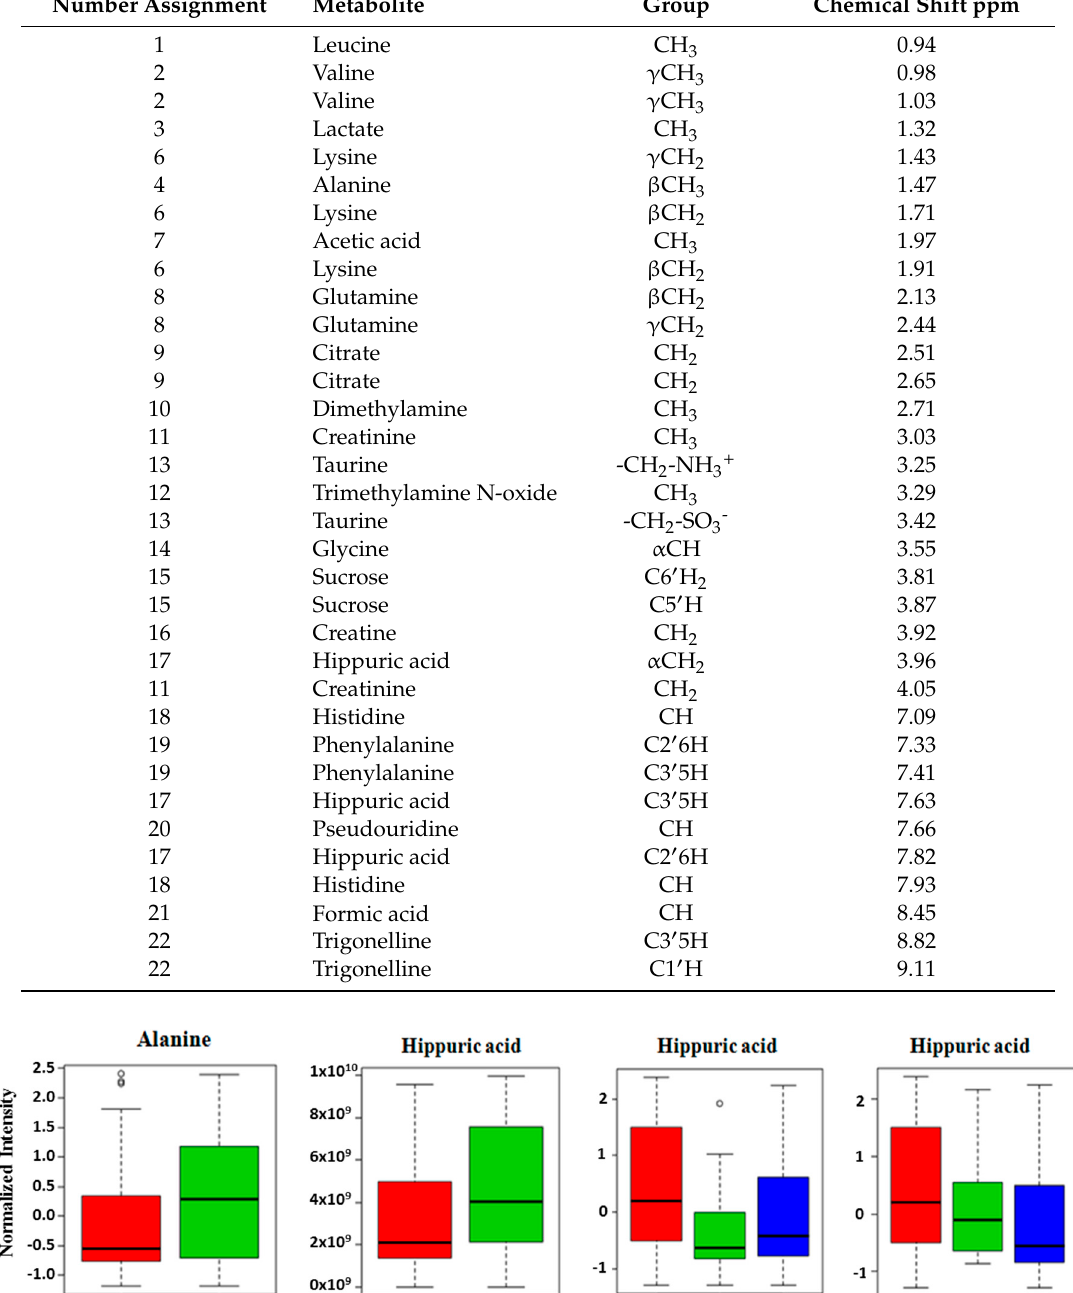
Table 1. Assignment of the main metabolites identified in 1D 1 H NMR urine spectra.